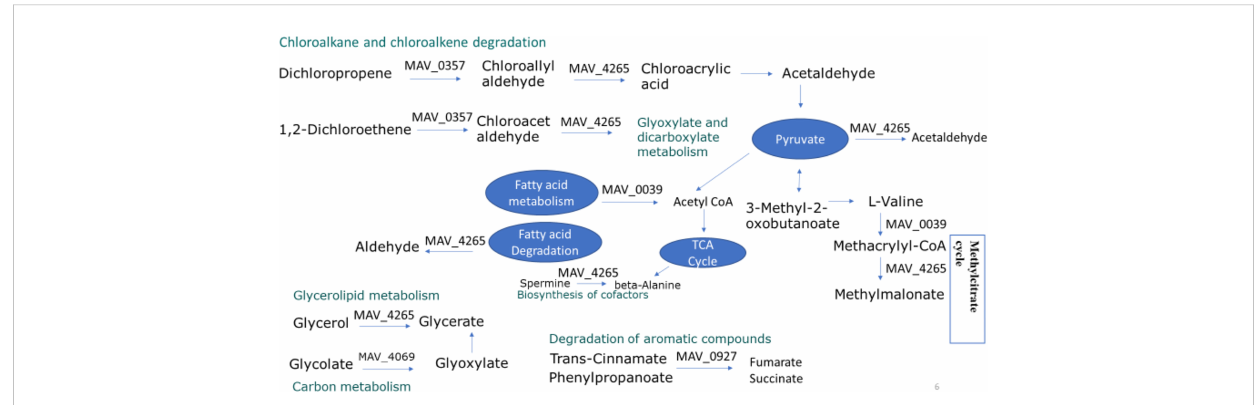
FIGURE 6 Upregulated metabolic pathways of M. avium in anaerobic and bio fi lm conditions. Synthesized proteins identi fi ed during different growth conditions (anaerobic and bio fi lm) was compared with the levels of corresponding protein found in standard growth condition (aerobic). The induction reaching 1.5-fold or higher in comparison to aerobic are presented. MAV_0357, haloalkane dehalogenase, MAV_0039, putative acyl-CoA dehydrogenase, MAV_4265, aldehyde dehydrogenase (NAD) family protein, MAV_4069 KatE catalase HPII, MAV_0927 conserved hypothetical